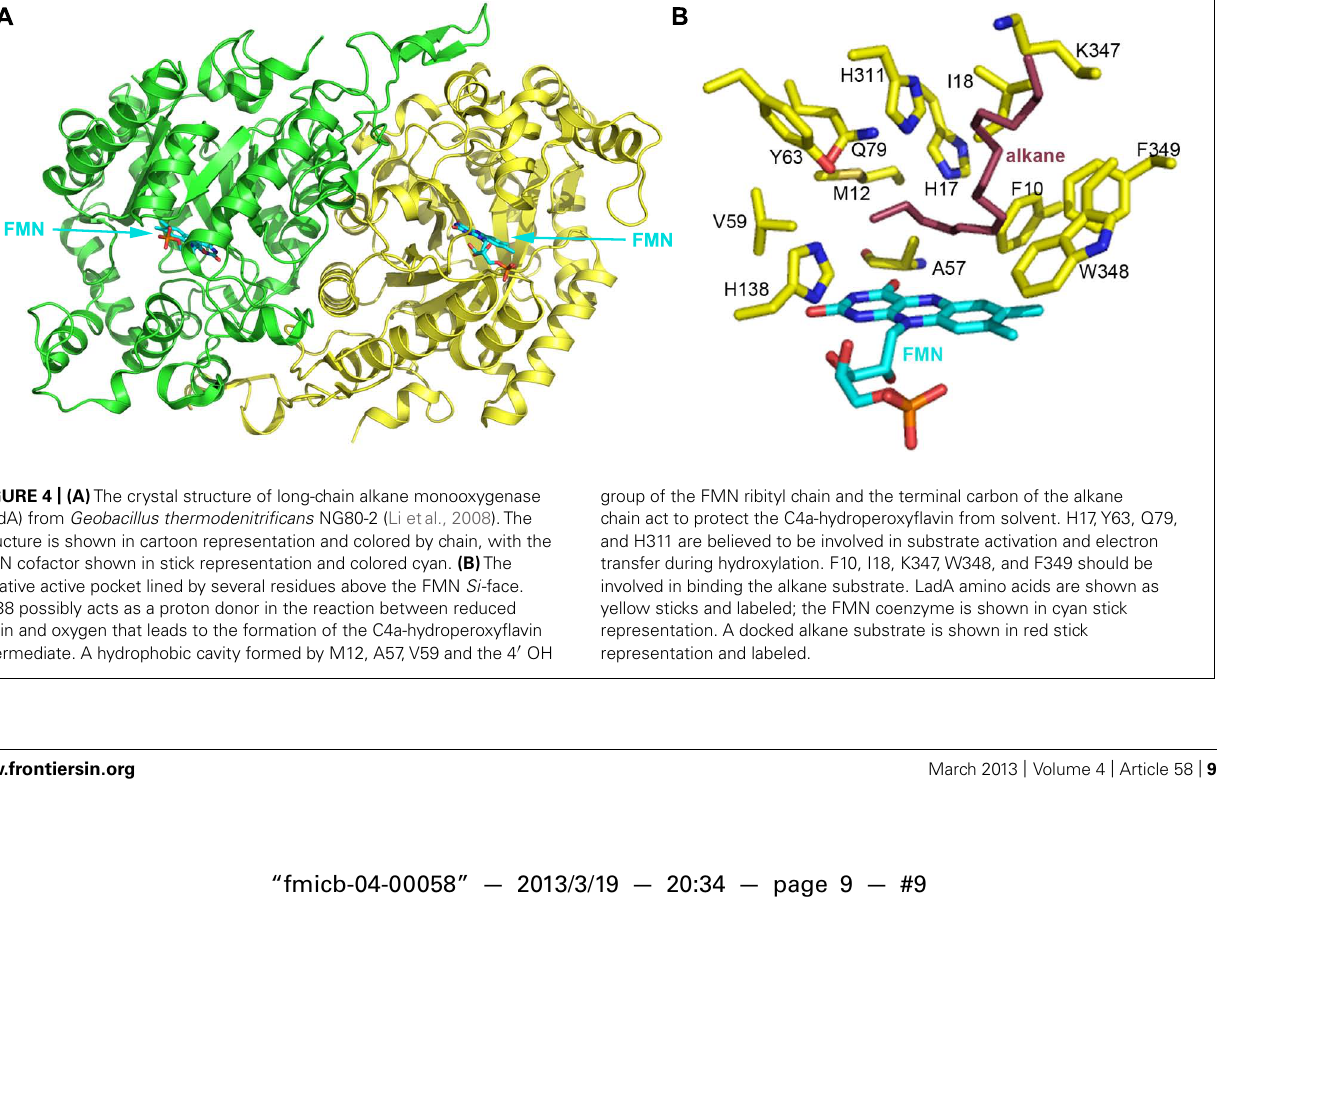
group of the FMN ribityl chain and the terminal carbon of the alkane chain act to protect the C4a-hydroperoxyflavin from solvent. H17,Y63, Q79, and H311 are believed to be involved in substrate activation and electron transfer during hydroxylation. F10, I18, K347,W348, and F349 should be involved in binding the alkane substrate. LadA amino acids are shown as yellow sticks and labeled; the FMN coenzyme is shown in cyan stick representation. A docked alkane substrate is shown in red stick representation and